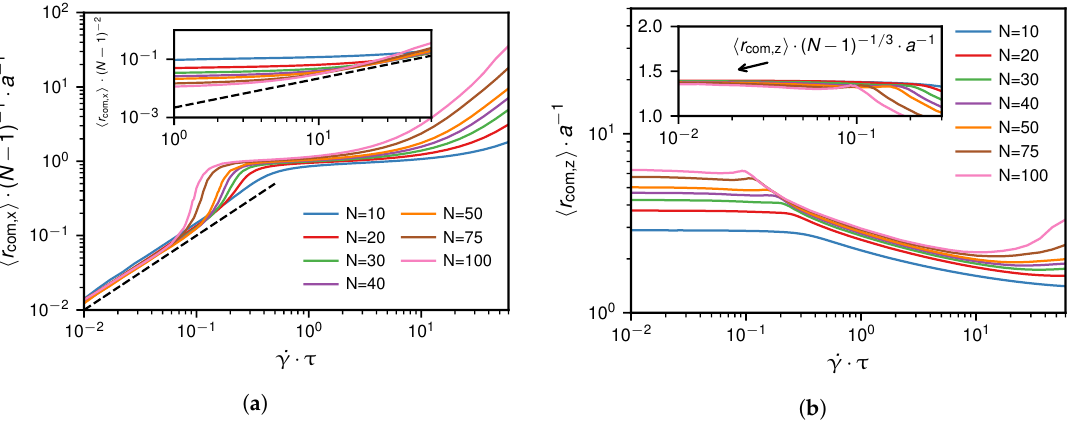
Figure 10. Grafted scenario: Subfigures ( a , b ) show the scaling collapse of (cid:104) r com,x (cid:105) and (cid:104) r com,z (cid:105) with respect to the monomer number as a function of the shear rate ˙ γ according to Equation (16) and (17). The dashed lines in subfigure ( a ) have slopes one and illustrate the proportionality to ˙ γ